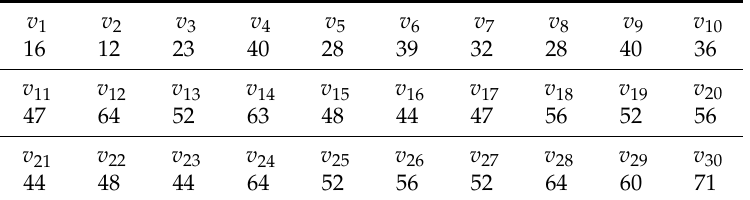
Table 2. Delay under traditional scheme.